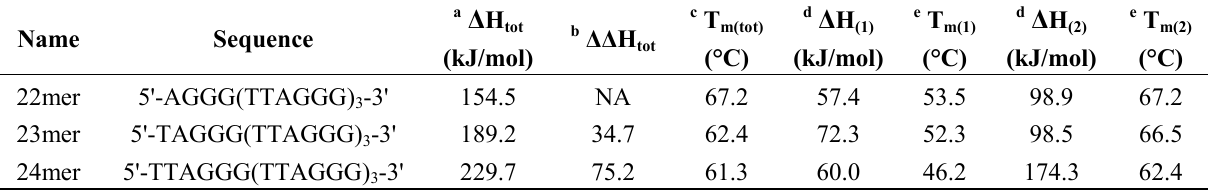
Table 1. Summary of thermal denaturation data derived from DSC